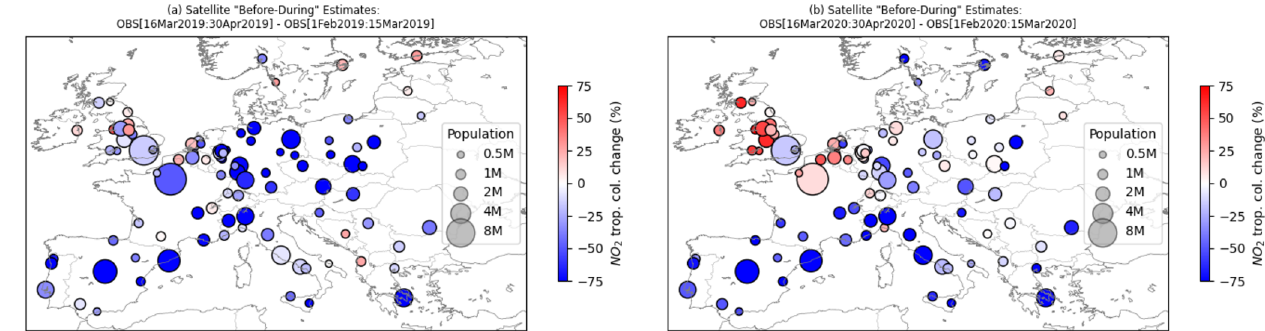
Figure 3. Before–during estimates of TROPOMI tropospheric NO 2 column change (%) for urban areas above 0.5 million inhabitants in 2019 (a) and 2020 (b) . The diameter of the circles is proportional to the population count in each urban area.